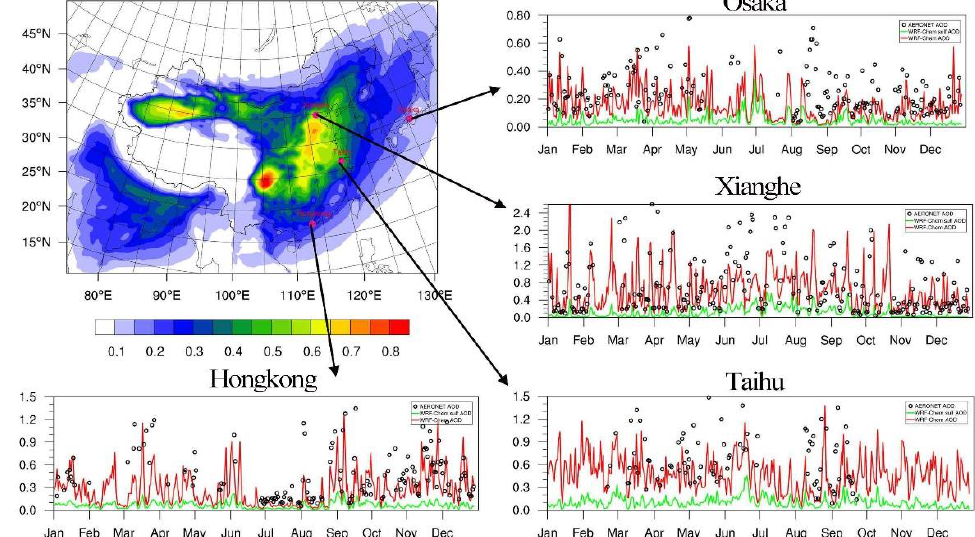
Figure 1. Daily aerosol optical depth (AOD) from the Aerosol Robotic Network (AERONET) measurements (black dots) at 500 nm and the total AOD (red) and sulfate AOD (green) at 500 nm from Weather Research and Forecasting model coupled with Chemistry (WRF-Chem) simulations during the simulation period at four sites over East Asia in 2010.